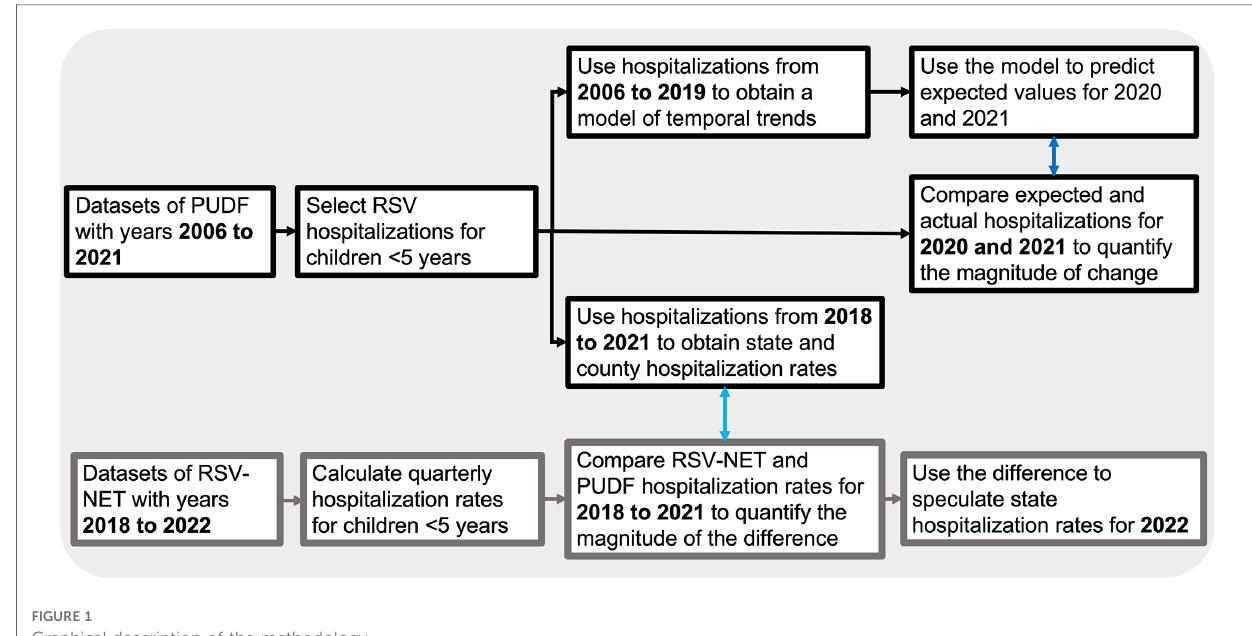
FIGURE 1 Graphical description of the